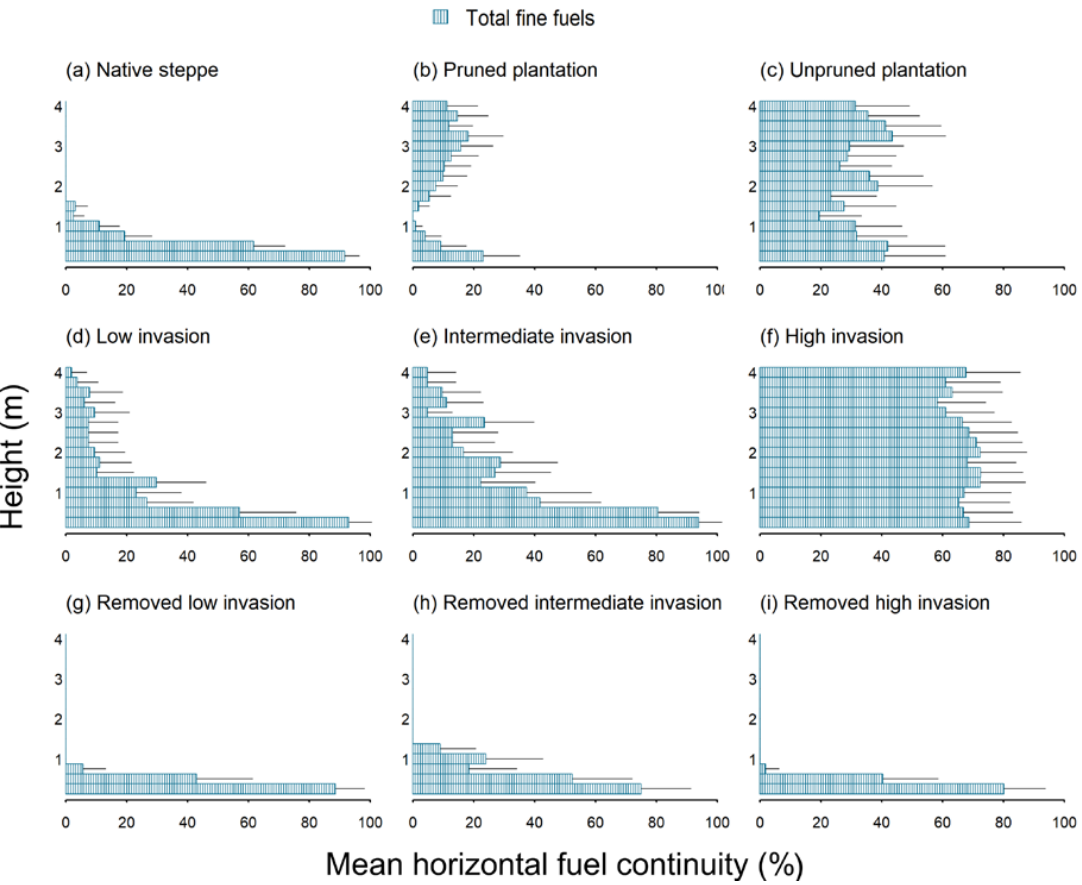
Figure 2. Mean horizontal total (live and dead) fuel continuity (expressed as a percentage) (±SE) for each 0.25 m height class at each of the nine treatments: native steppe ( a ), pruned plantation ( b ), unpruned plantation ( c ), low invasion level ( d ), intermediate invasion level ( e ), high invasion level ( f ), removed low level invasion ( g ), removed intermediate level invasion ( h ), and removed high level invasion ( i ). Forests 2018 , 9 , x FOR PEER REVIEW